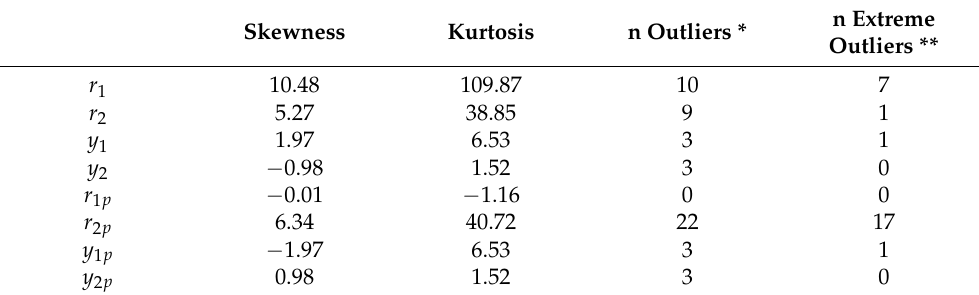
n Extreme Outliers **